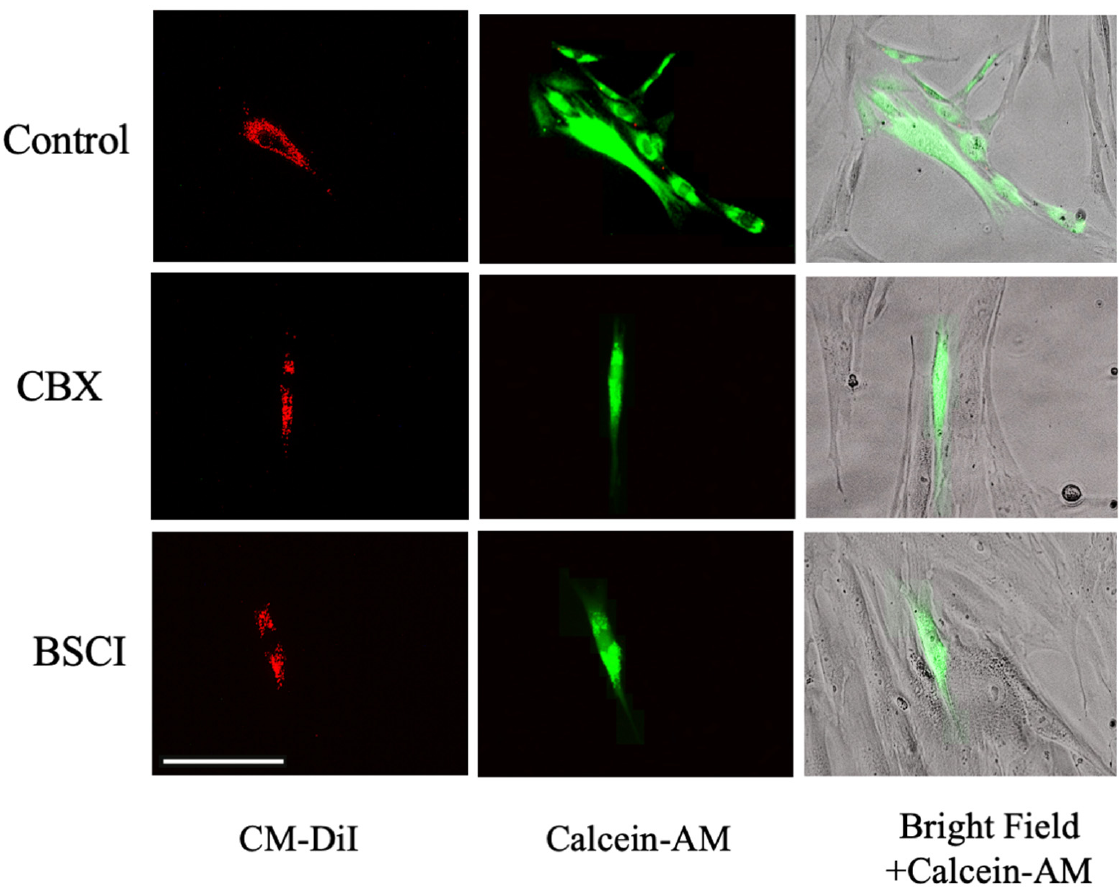
Figure 3. Myocyte-to-myocyte Calcein-AM dye transfer ‘parachute’ assay. Fluorescence images of myocyte ‘parachute’ assay: untreated myometrial cells (‘acceptor’) were grown in monolayer on glass cover slips; ‘donor’ myocytes were loaded with permeable Calcein-AM dye (10 µ g/mL, green) and non-transferable cell tracker CM-DiI (5 µ g/mL, red) and added in ratio 1:100. Cells grown in monolayer were incubated for 24 h with/out Carbenoxolone (CBX, 150 nM) or BSCI (FX125L, 250 nM), or Vehicle (Control). Representative images taken on a DMI spinning disc confocal microscope (Leica, Wetzlar, HE, Germany) identify ‘donor’ cells loaded with red CM-DiL; green fluorescent Calcein dye show transfer from ‘donor’ to ‘acceptor’ cells in Control; this transfer is fully blocked by CBX and BSCI. Scale bar = 100 µ m. Magnification is 200 × g